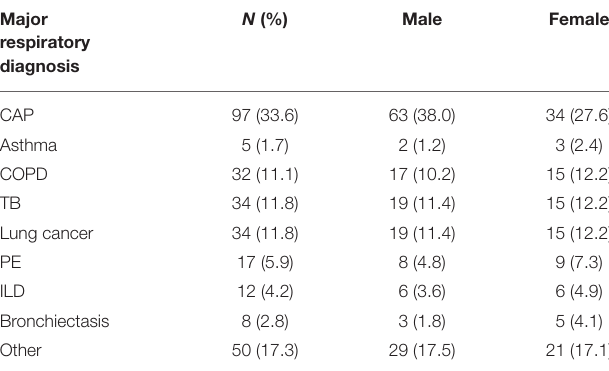
TABLE 1 | Distribution of different major respiratory diagnoses among patients included in the study ( n =